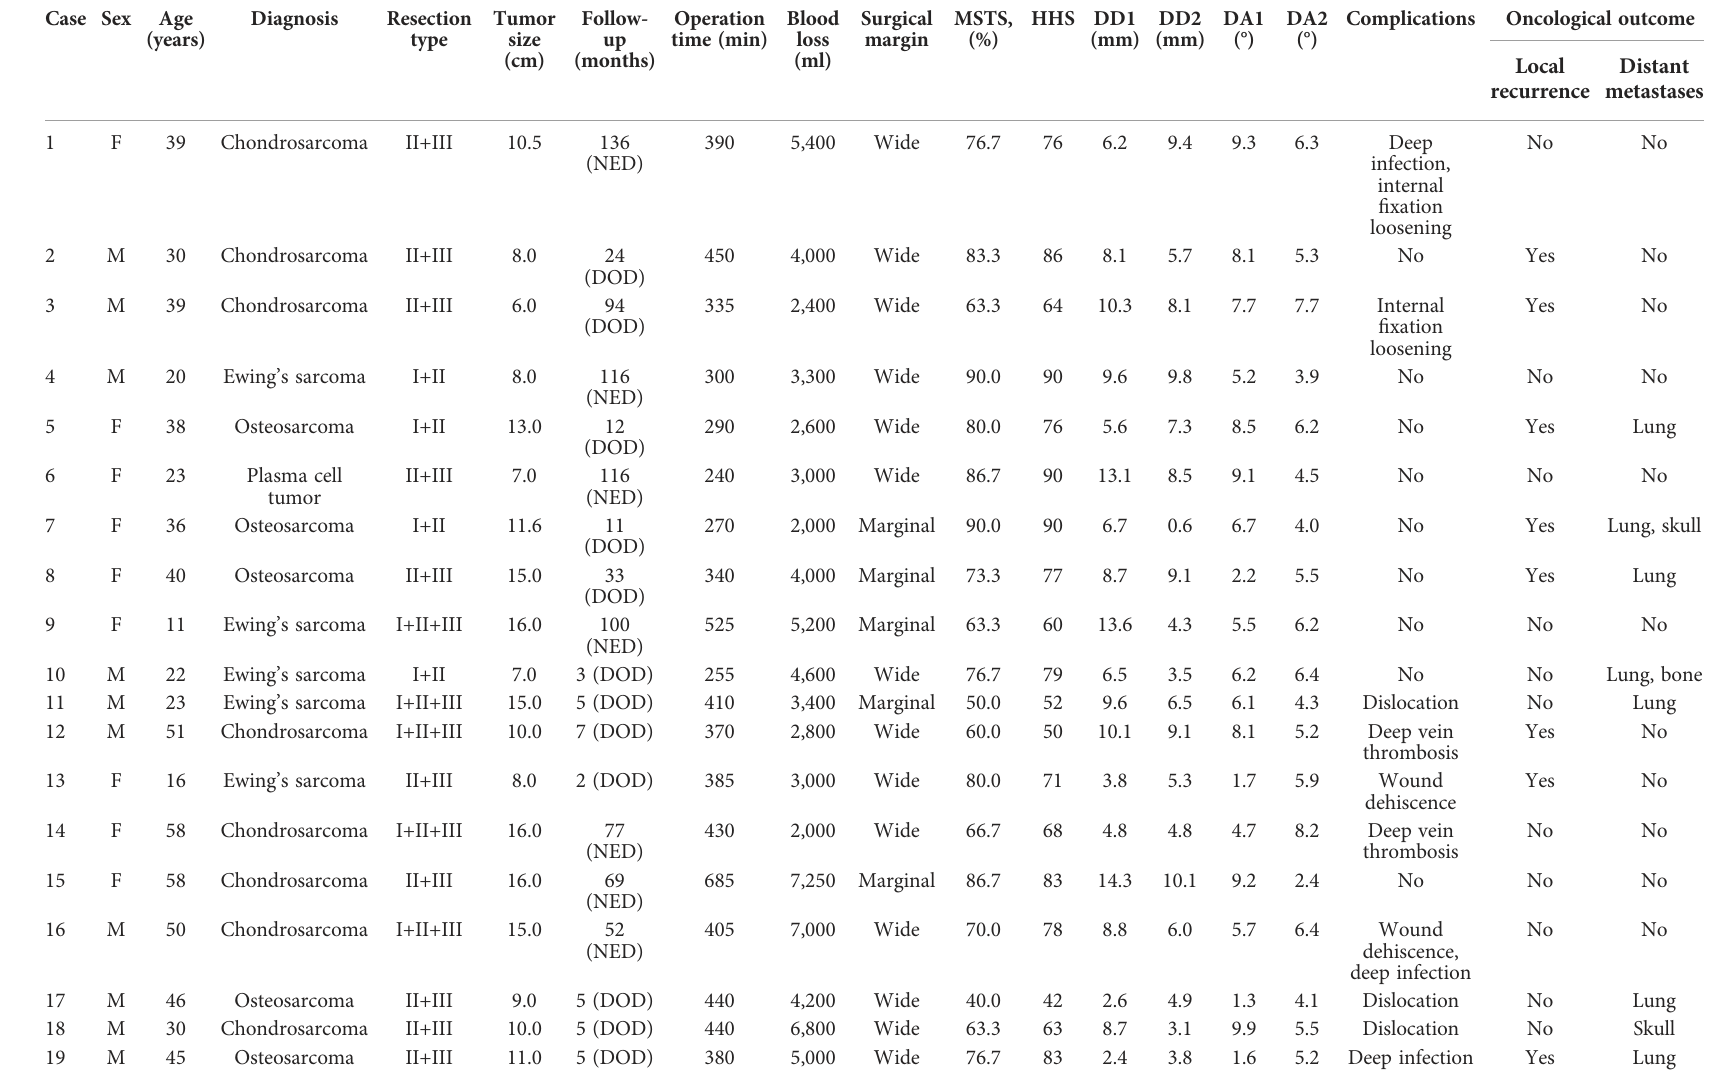
TABLE 2 Patient demographics and clinical data in the SRCS